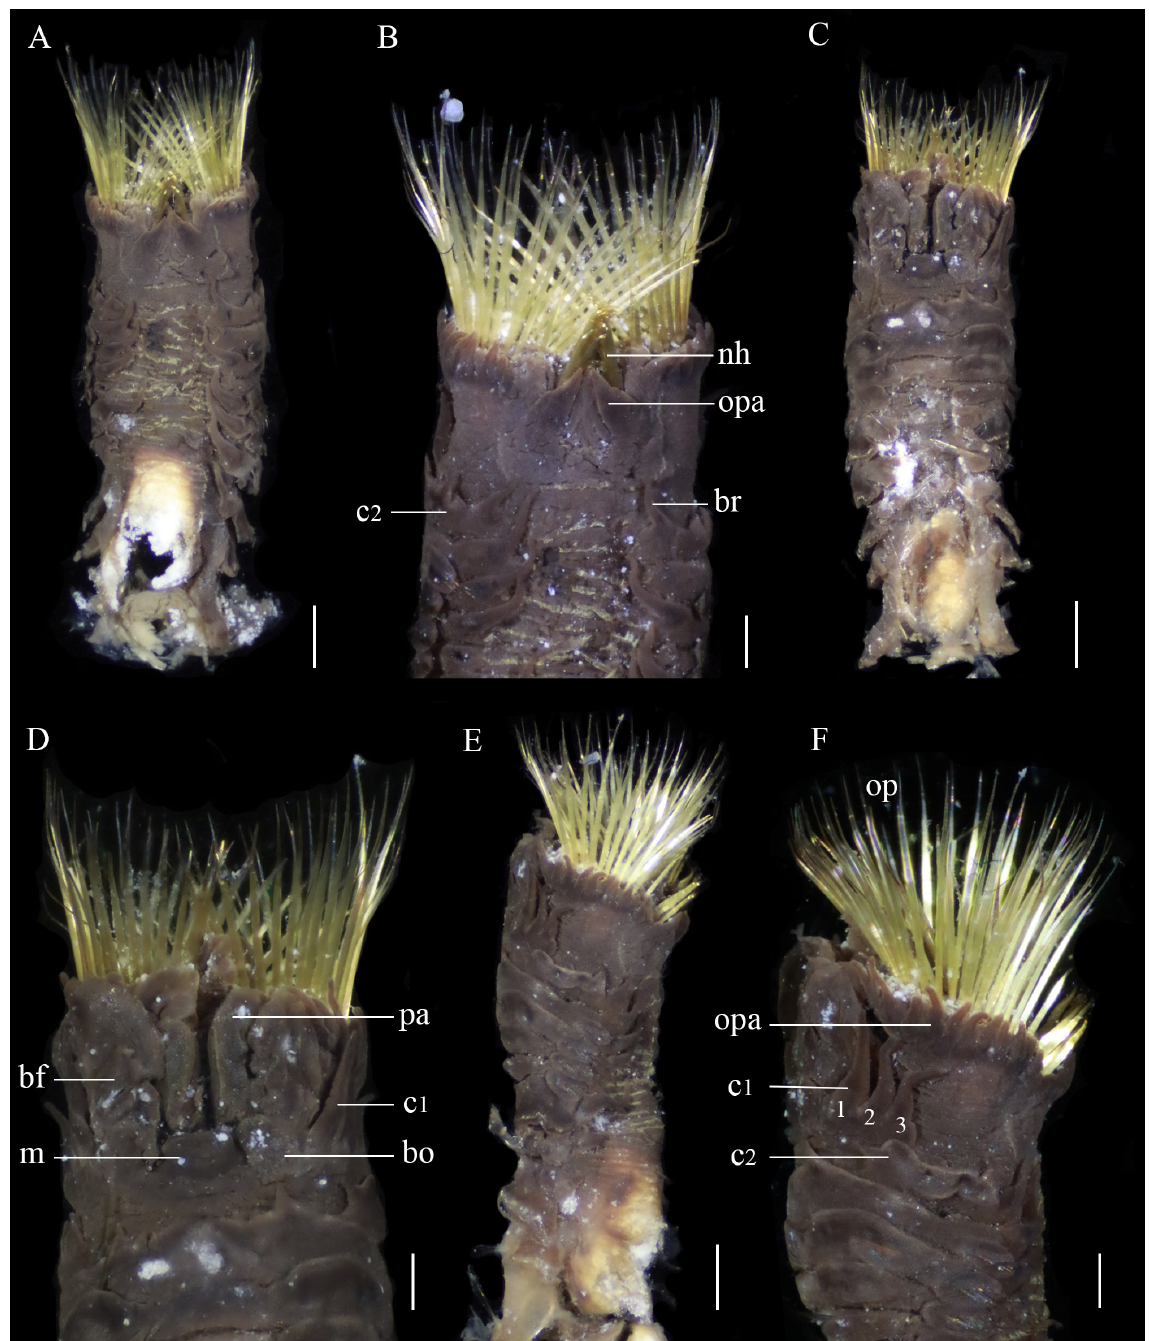
Fig. 16. Phalacrostemma sp. (UMML-22.1194). A . Complete specimen, dorsal view. B . Anterior region, dorsal view. C . Complete specimen, ventral view. D . Anterior region, ventral view. E . Complete specimen, lateral right view. F . Anterior region, lateral view. Abbreviations: bo = building organ; br = branchia; c1 = cirri 1 st thoracic segment; c2 = cirri 2 nd thoracic segment; m = mount; mo = median organ; nh = nuchal hooks; op = outer paleae; opa = opercular papillae. Numbers indicate the cirri. Scale bars: A, C, E = 1 mm; B, D, F = 0.5